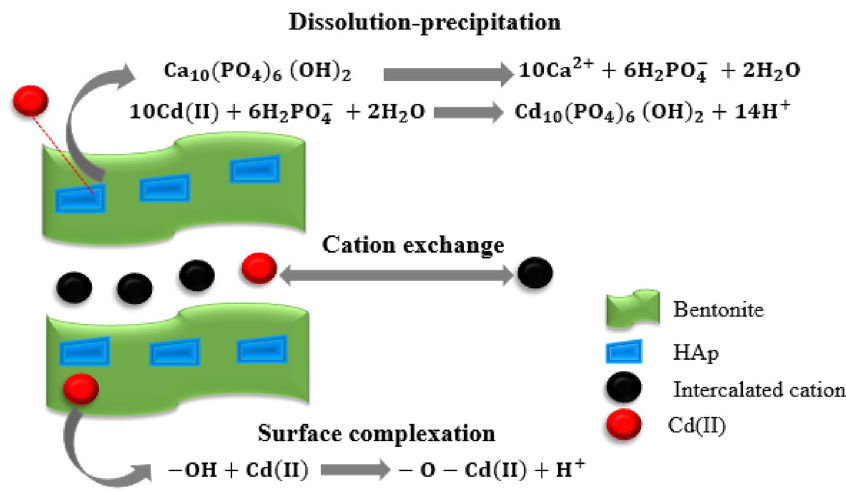
Figure 11. The possible mechanism of Cd(II) adsorption on HAp/bentonite